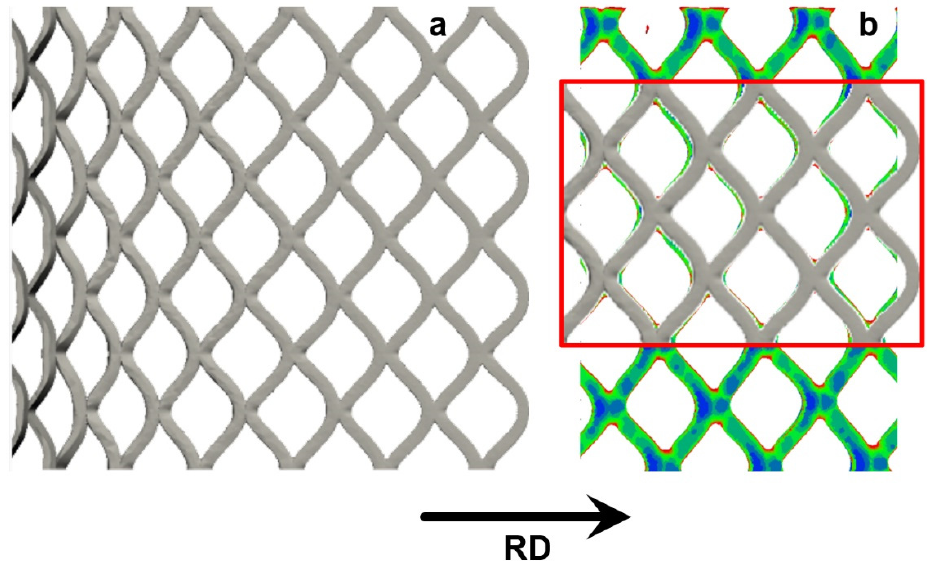
Figure 5. The transformation of expanded mesh geometry as a reinforcing component during the roll bonding of the aluminum matrix: ( a ) development of the mesh geometry along the deformation zone (rolling reduction 40%, “quarto” mill) obtained after the FE simulation using QForm 9.0.10 software; ( b ) the fragment of simulated geometry overlapping with the CT reconstruction image of the mesh inlay after the experimental rolling of the aluminum composites.